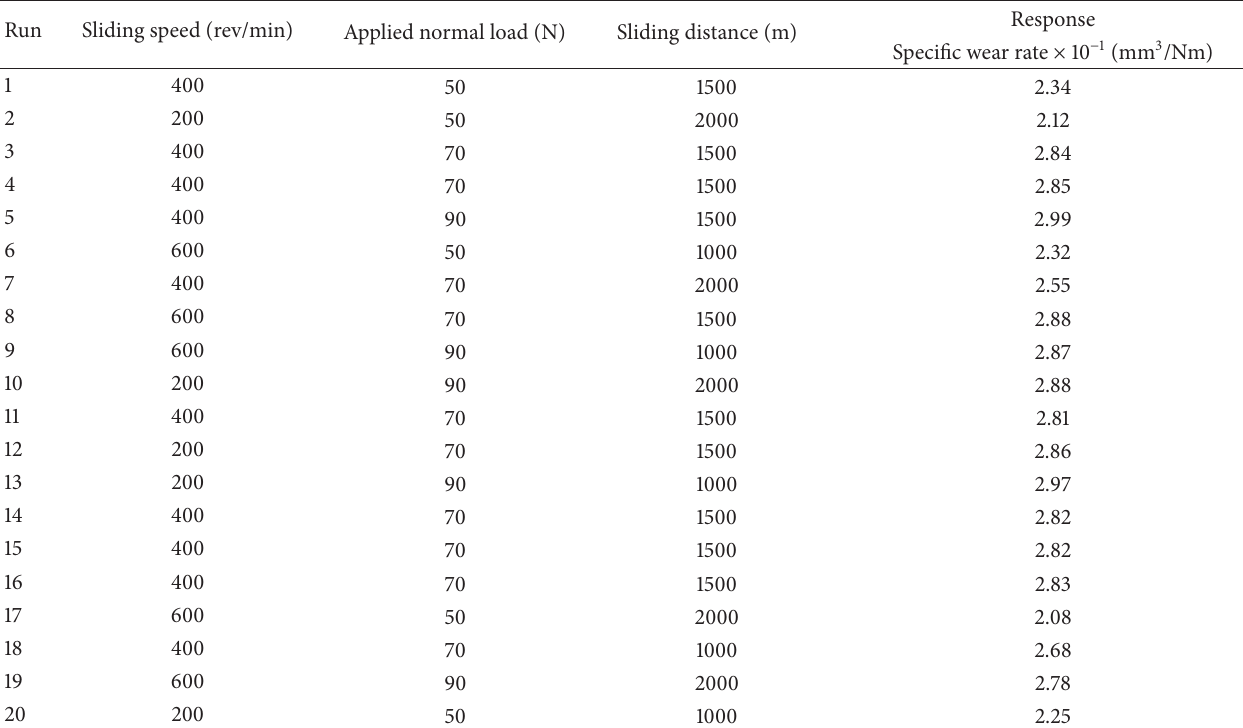
Table 3: Design layout matrix and experimental results.